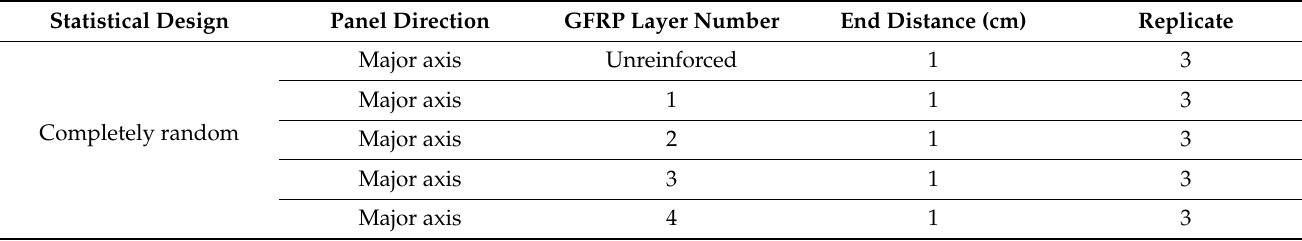
Figure 2. Placement of metal connector and fastener in CLT specimens. Table 4. Properties of lag screw (8 mm) [36]. Table 1. Statistical groups for investigating the effect of GFRP layer number on lateral